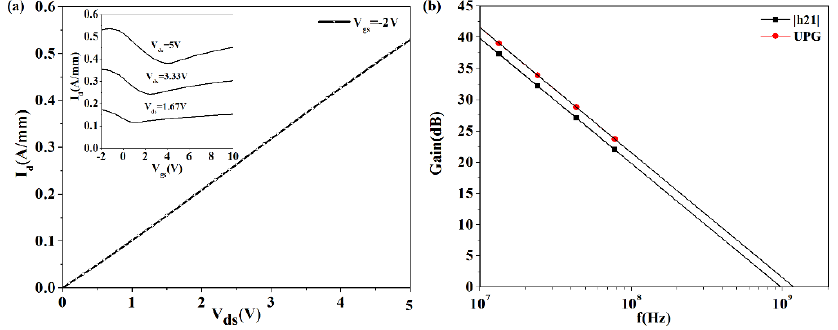
Figure 6. The I d -V d characteristics and I d -V g characteristics (inset) of the baseline GFET-1. RF characteristics (Current Gain, |h 21 | and Unilateral Power Gain, UPG) of the baseline GFET-1 plotted in decibel (dB) with respect to frequency.